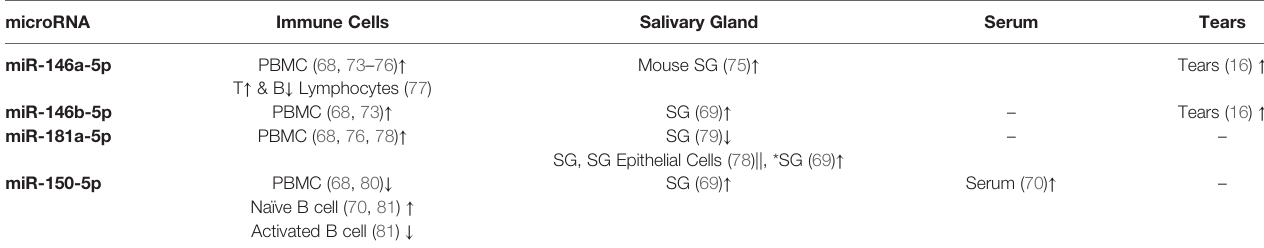
TABLE 3 | Literature summary for previous miRNA hits in studies on SS.